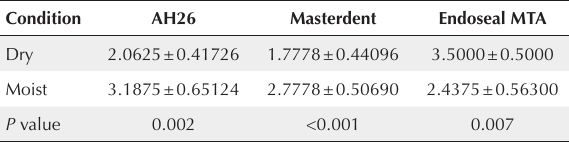
Table 1. Mean leakage by moisture Condition